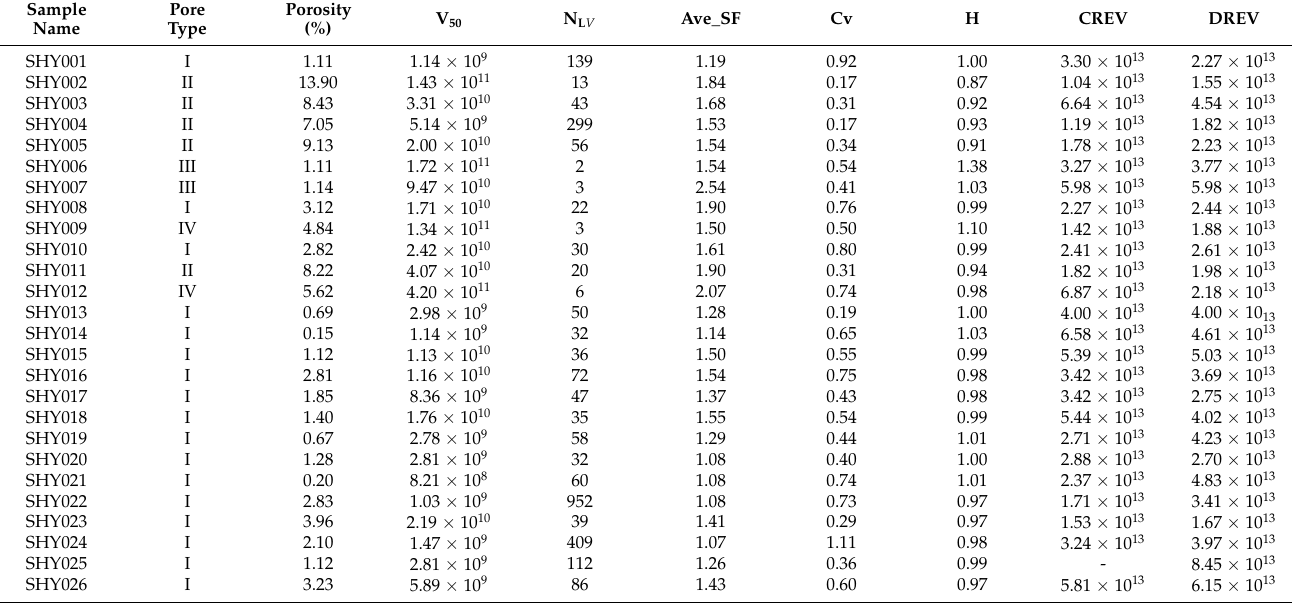
Table 1. The calculating parameters and determining the REV.